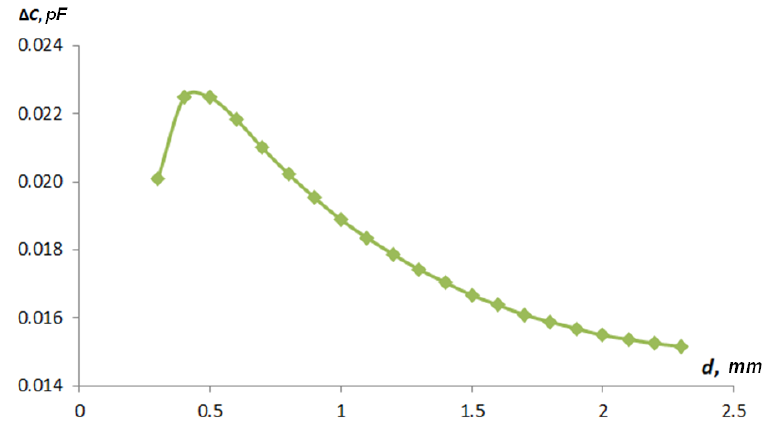
Figure 16. Graphs of the influence of the fringe effect on the total capacity of the distance to the grounded control object for the type 2 sensor.